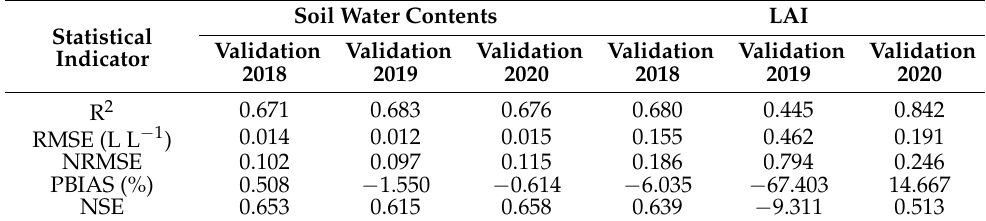
Table 3. Statistical parameters for the agreement between model simulations and observed data.